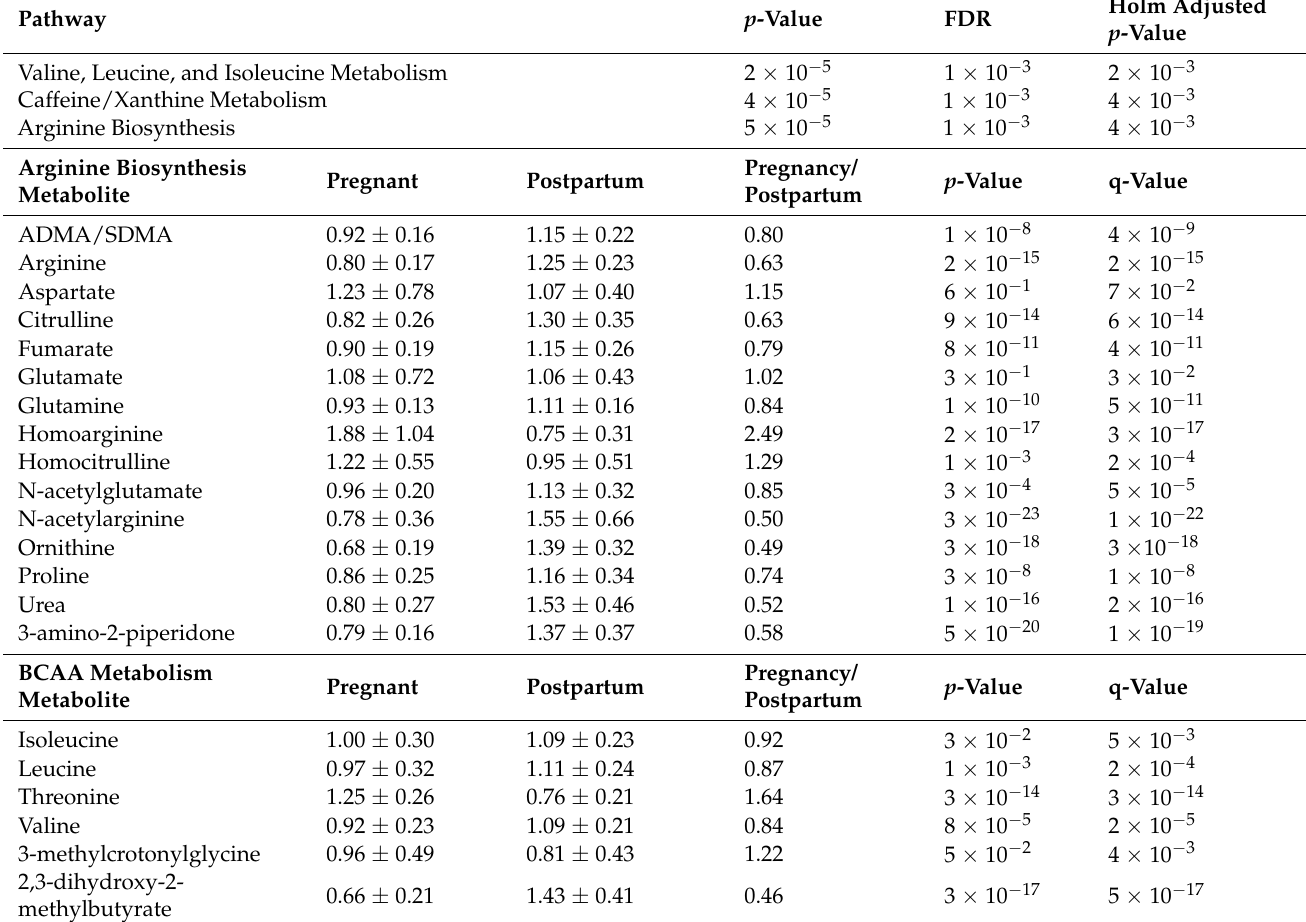
Table 2. Pregnant and postpartum pathway and metabolite peak area data from metabolomics